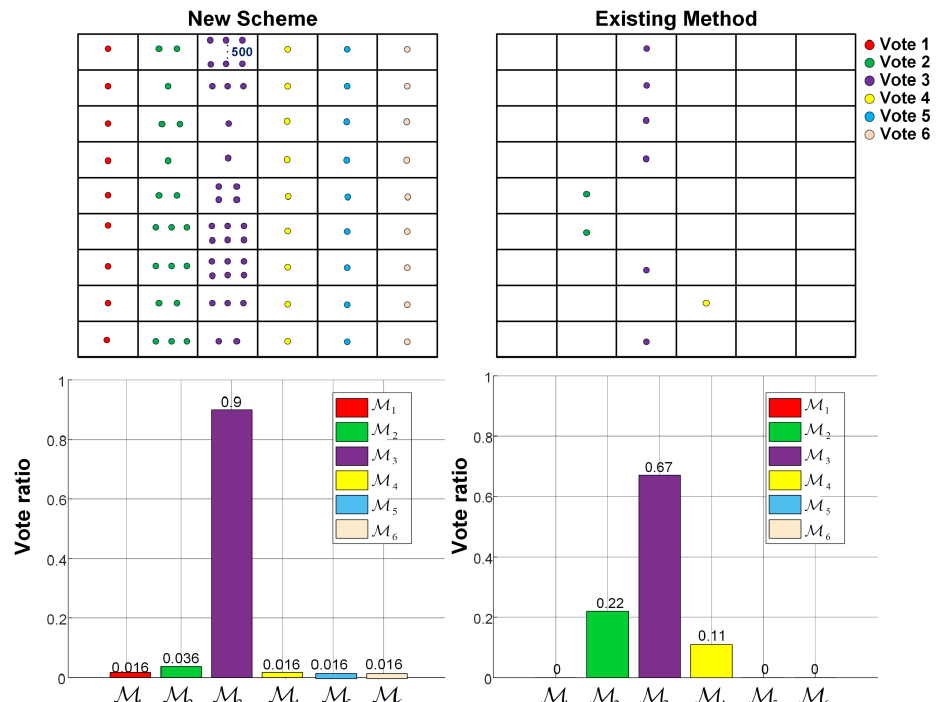
Figure 6. Illustration of different voting results from our proposed new CAMC scheme and the existing CAMC method in [23] for a certain sensing